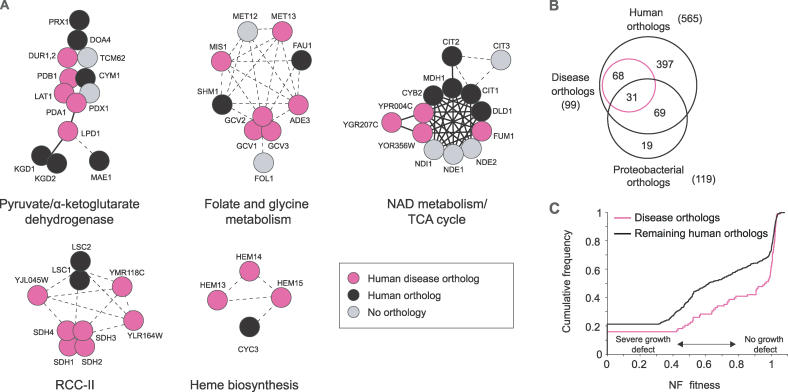
Properties of Yeast Orthologs to Human Disease Genes within the Mitochondrial System(A) Five modules enriched in human disease gene orthologs. Node color identifies human orthologs to yeast genes with and without associated Mendelian diseases (OMIM database). Proteins that belong to physical complexes are shown by overlapping nodes or in some cases are connected by solid lines; functional associations are shown by dotted lines. Disease genes within the same functional module had a tendency to have similar clinical phenotypes: glutaricaciduria II (NAD metabolism/tricarboxylic acid cycle), glycine encephalopathy (folate and glycine metabolism), mainly susceptibility to hereditary pheochromocytoma and paraganglioma (RCC-II), and variants of inherited disease of porphyrin metabolism (heme biosynthesis). Table S6 contains descriptions for each disease gene.(B) Conservation of disease genes to proteobacteria. Venn diagram of the overlap of yeast genes having human orthologs, proteobacterial orthologs, and human disease gene orthologs. Of the proteins with a disease ortholog, 31% (31/99) have a proteobacterial ortholog—whereas only 18% (100/565) of all human orthologs have a proteobacterial ortholog (hypergeometric test, p < 10−4).(C) Fitness distribution of yeast orthologs of disease genes. Empirical cumulative distributions of NF fitness scores are shown for all human disease gene orthologs compared to the remaining human orthologs. NF fitness represents the growth and survival of single gene deletion mutants under respiratory conditions (NF carbon source): higher fitness represents a milder growth defect. As a group, disease orthologs have higher fitness (i.e., milder mutant phenotypes) (t-test, p < 0.01).